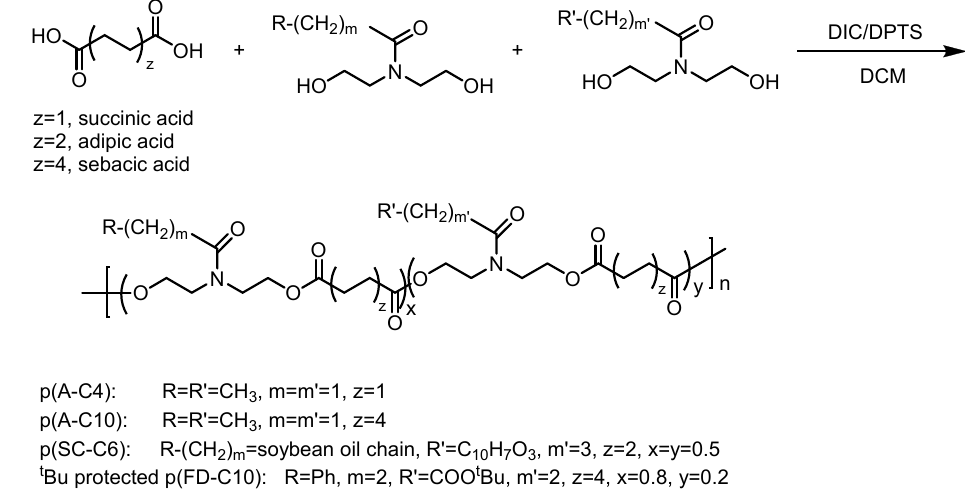
Figure 3. Synthesis of pendant functionalized polyesters.